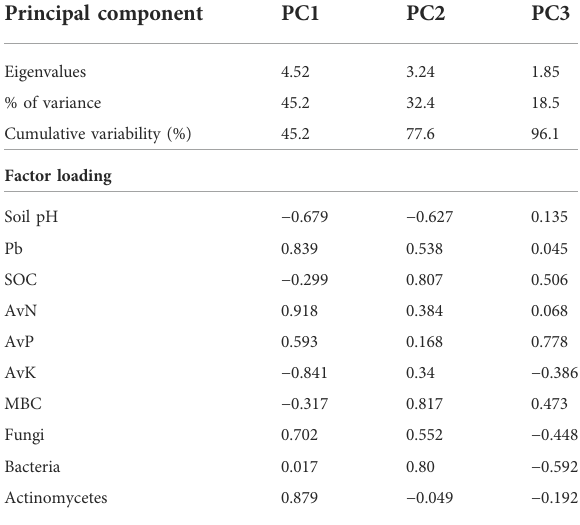
TABLE 1 Details of the rotated component matrix – eigenvalues and rotated sums of squared loadings in our present